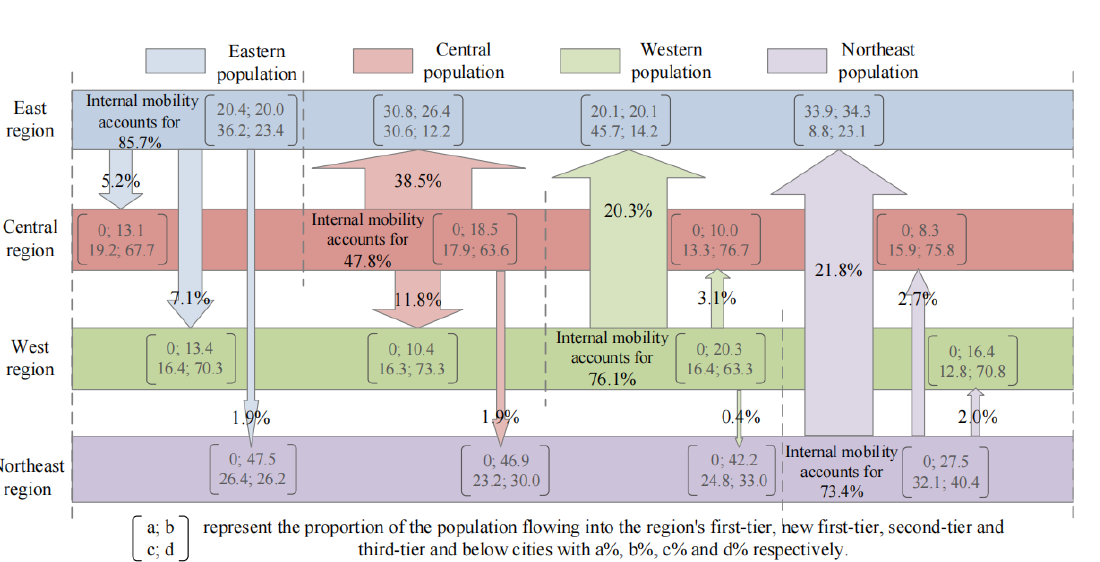
Figure 2. Direction of population movement by region, 2017.